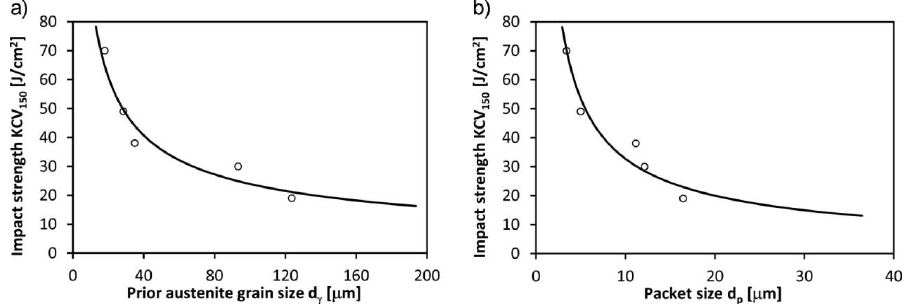
Figure 18. Influence of the prior austenite grain size ( a ) and martensite packet size ( b ) on the impact strength KCV 150 at 233K (−40 °C) for the Hardox 450 steel.